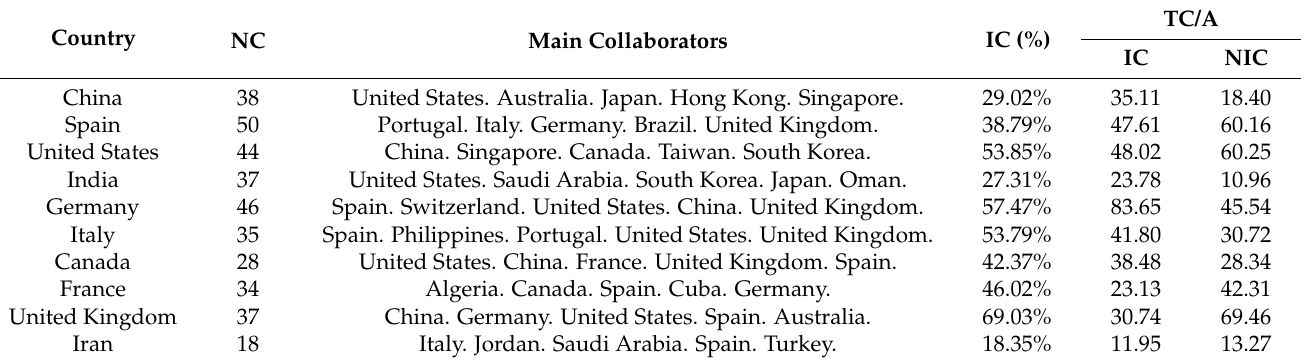
Table 8. International collaboration of the most prolific